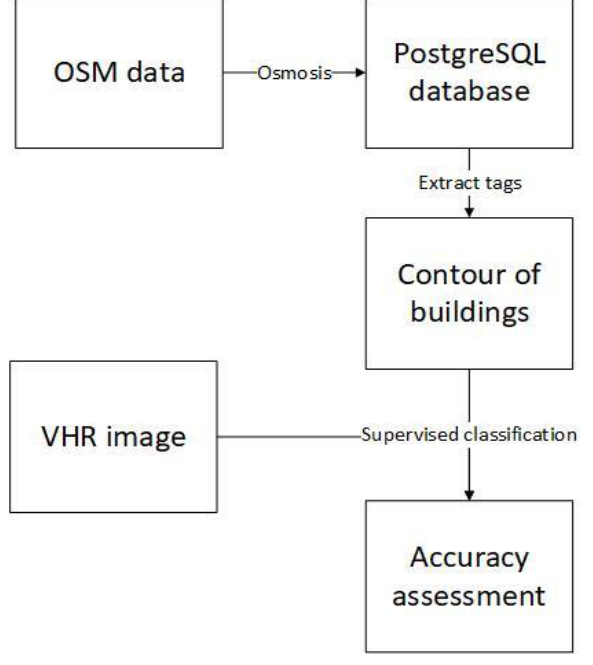
Figure 2. Workflow of the study method